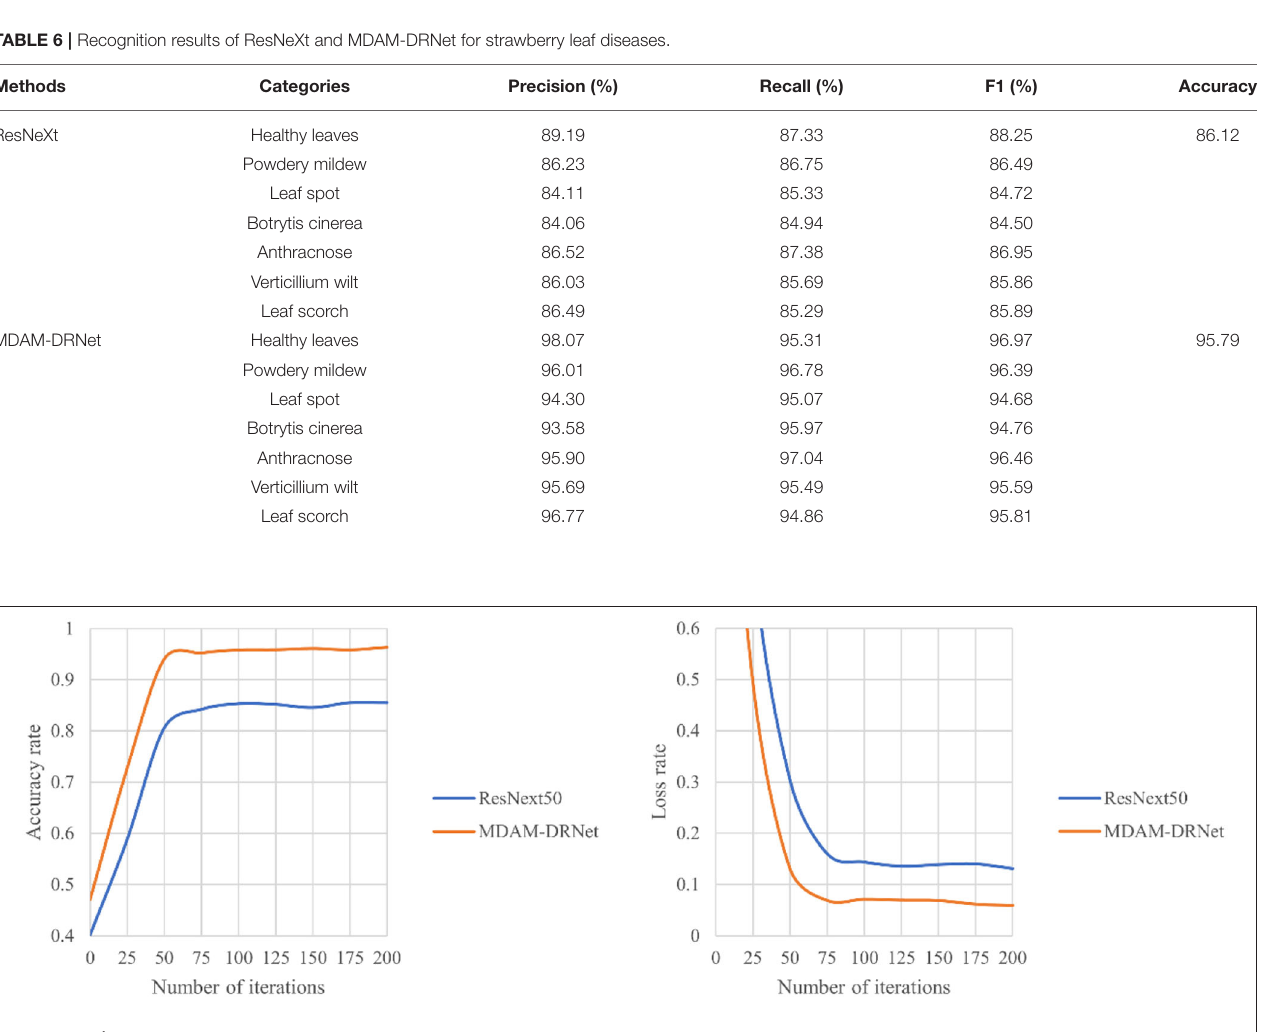
Frontiers in Plant Science |